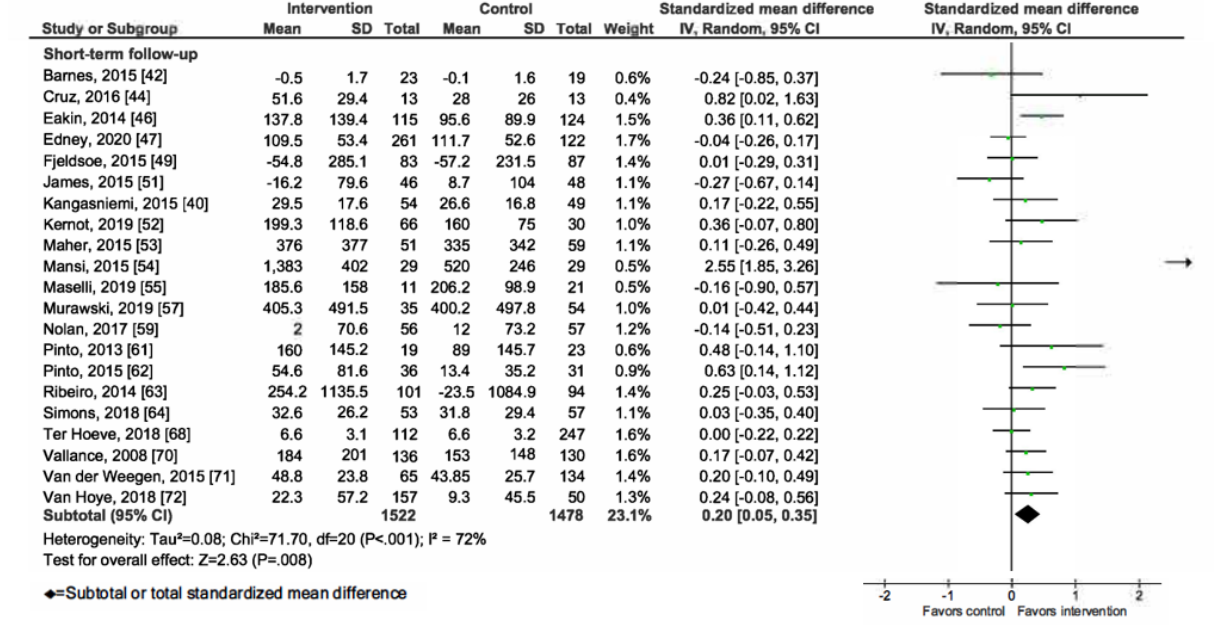
Figure 6. Primary outcome analysis for the outcome moderate-to-vigorous physical activity at timepoint short-term follow-up.